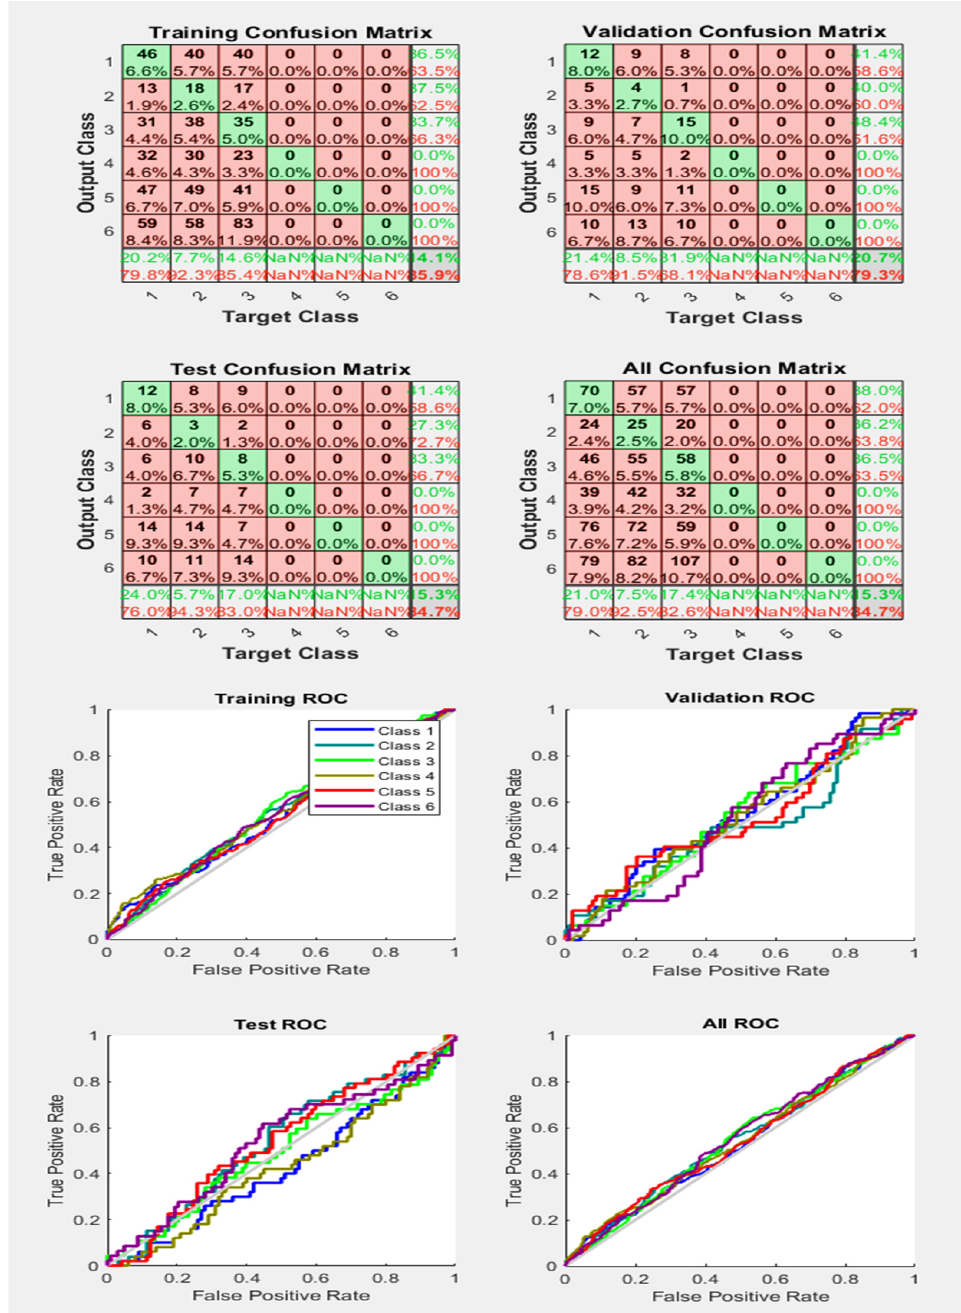
Figure 25. Neural Network Model ROC (Receiver Operating Characteristics) and Confusion Matrix for LM TrainFcn/Activation Function at level 9 (RMS) Features for Rotor Bar Fault with 84.7% Accuracy. Grey line shows diagonal of the ROC for indicating Class 1–6 lines are lying above or below or on it.